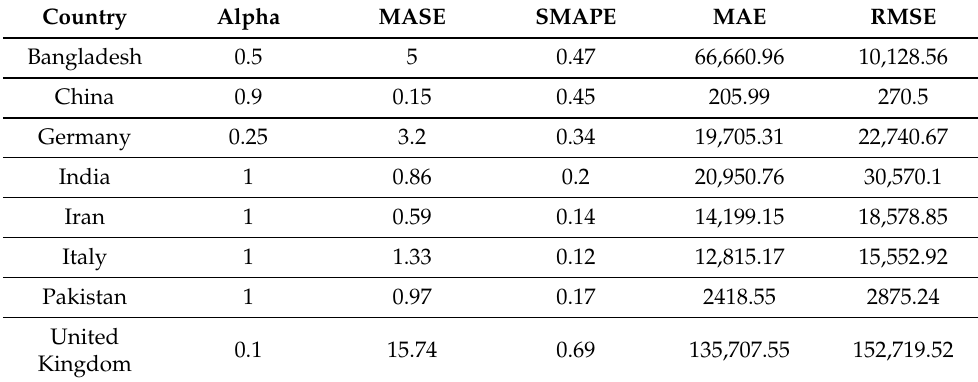
Table 5. Forecasting metric results for all active